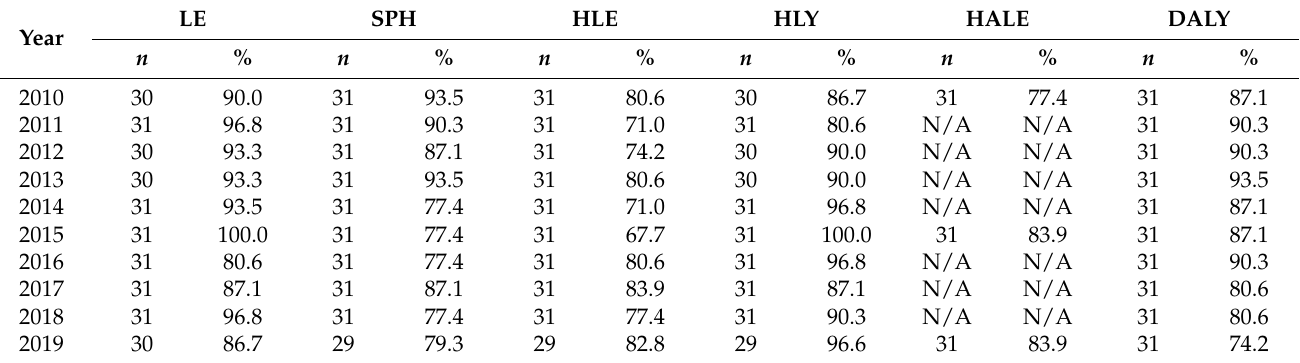
Table 2. Share of countries with rank differences for the total and the older population.